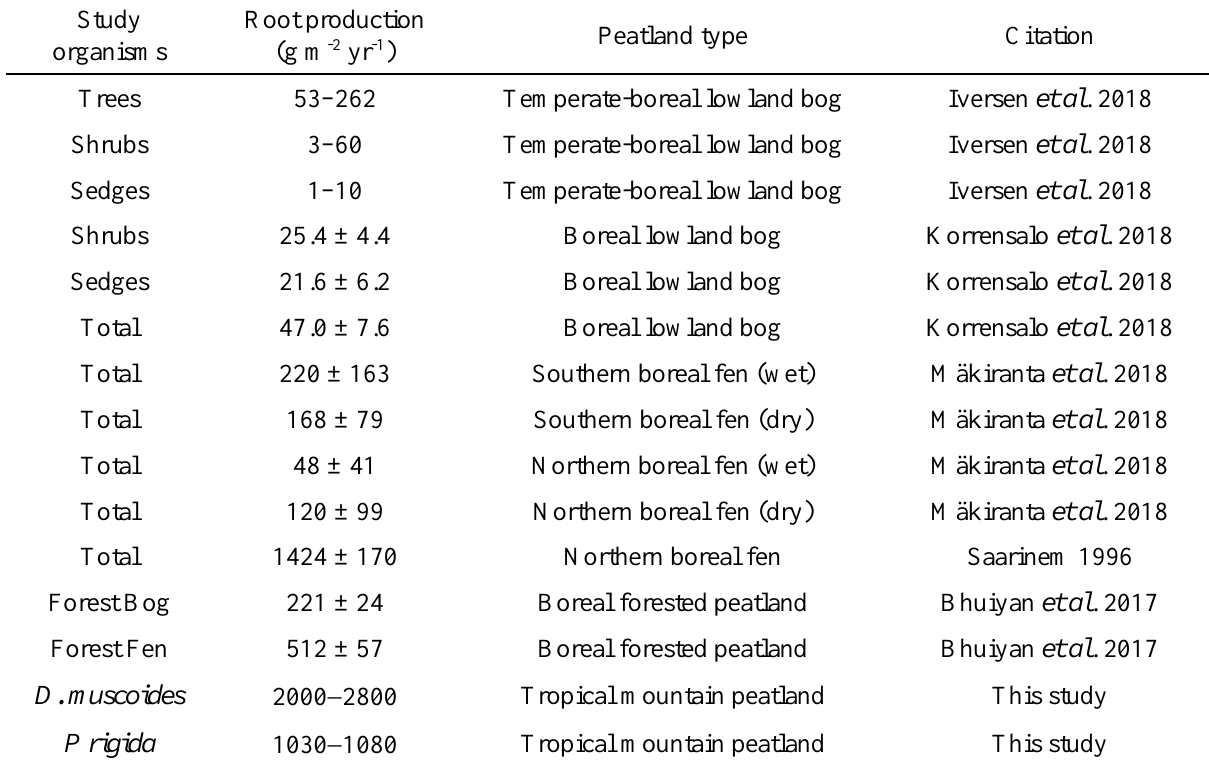
Table 3. Examples of root production estimates from the literature. The list does not represent a systematic review and is included only for the purpose of